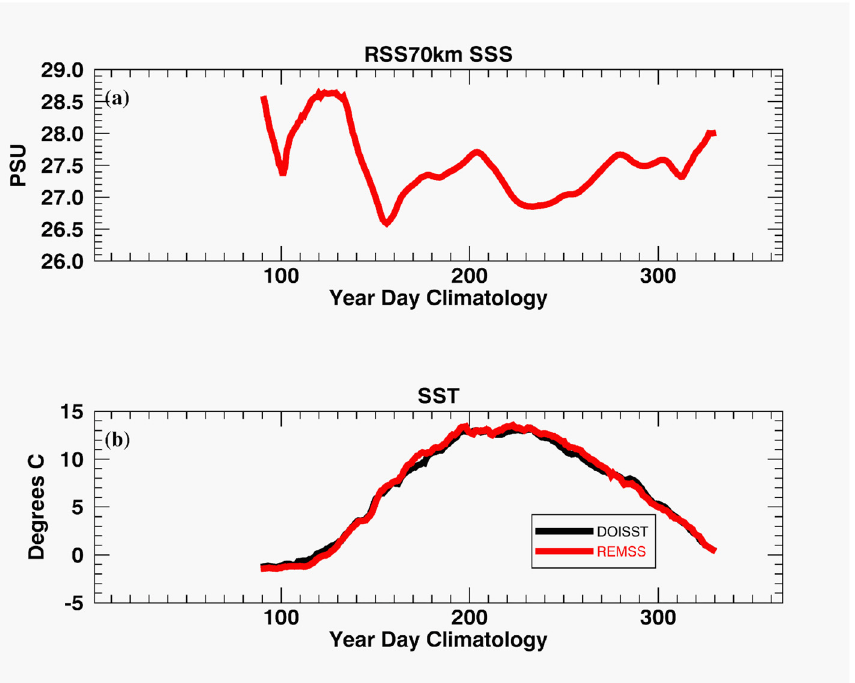
Figure 9. Daily climatologies for over the Y–K delta; ( a ) SSS, as derived from the RSS70 km SSS product; ( b ) SST, as derived from the DOISST and the MWIR SST analyses.